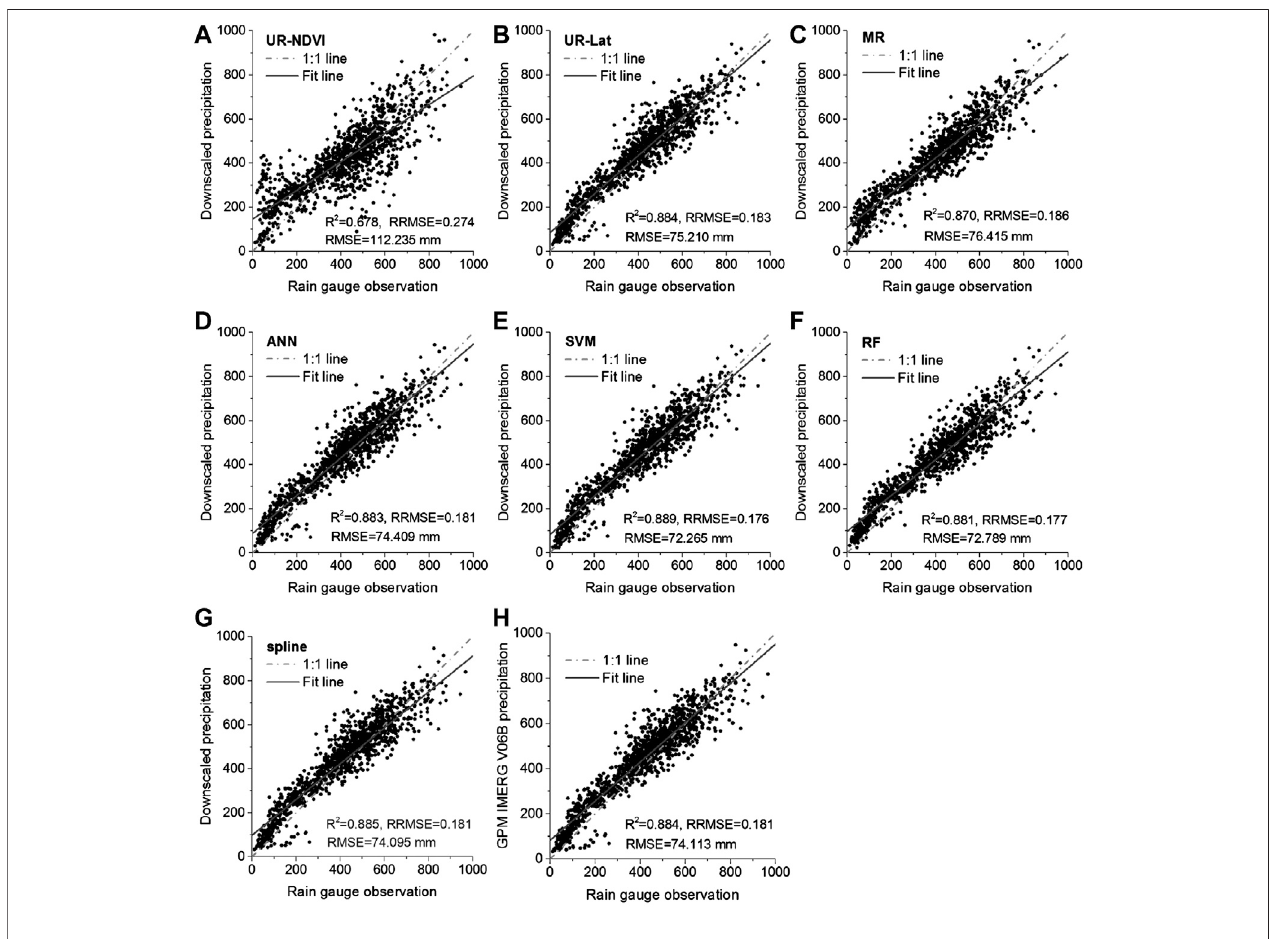
FIGURE 9 | Validation results of the downscaled 1 km IMERG precipitation after residual correction using the rain gauge observations from 2001 to 2015: (A – F) UR-NDVI, UR-Lat, MR, ANN, SVM, and RF; (G) spline interpolation; (H) validation result of the original IMERG precipitation.